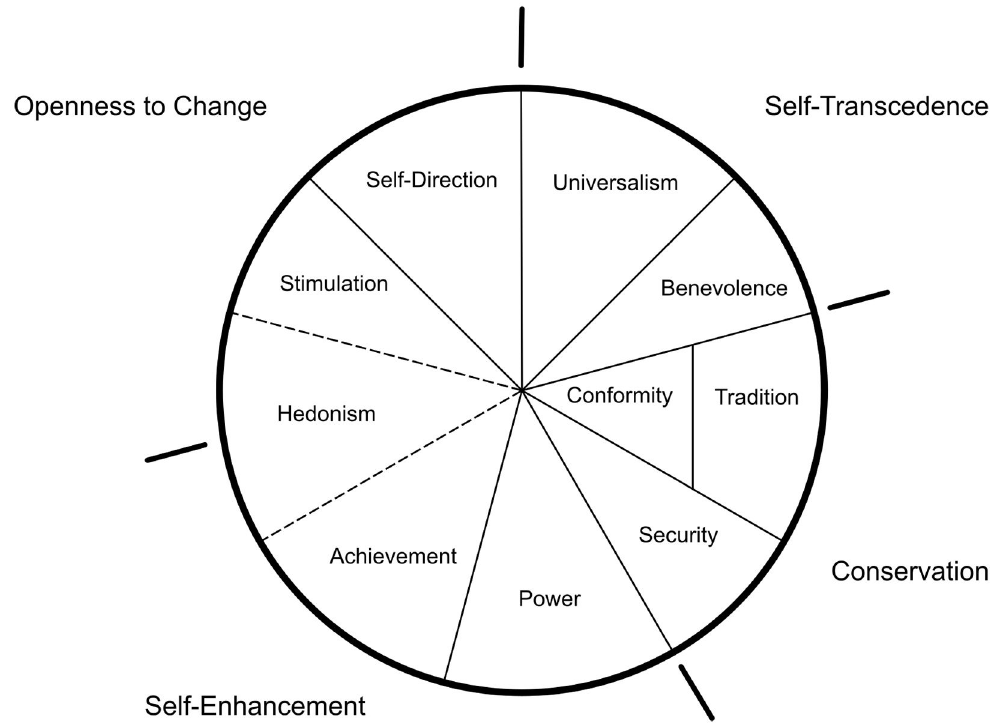
Figure 1. Dimensions and domains – Mayer (2001) adapted from Schwartz Value Model (Schwartz, 1994, p. 24-35)